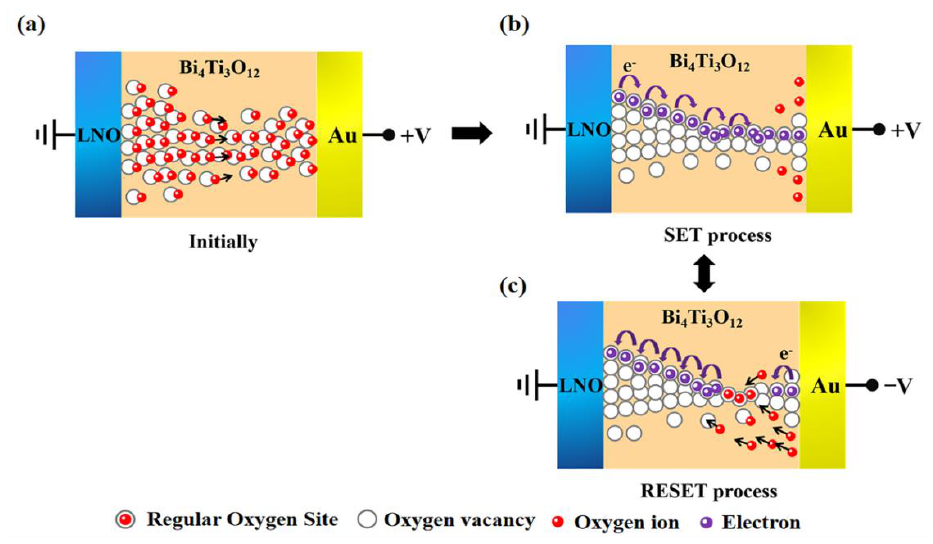
Figure 8. Model of an oxygen-vacancy-related filament. ( a ) Resistive switching at the initial state. ( b ) Set process of the device. ( c ) Reset process of the device.